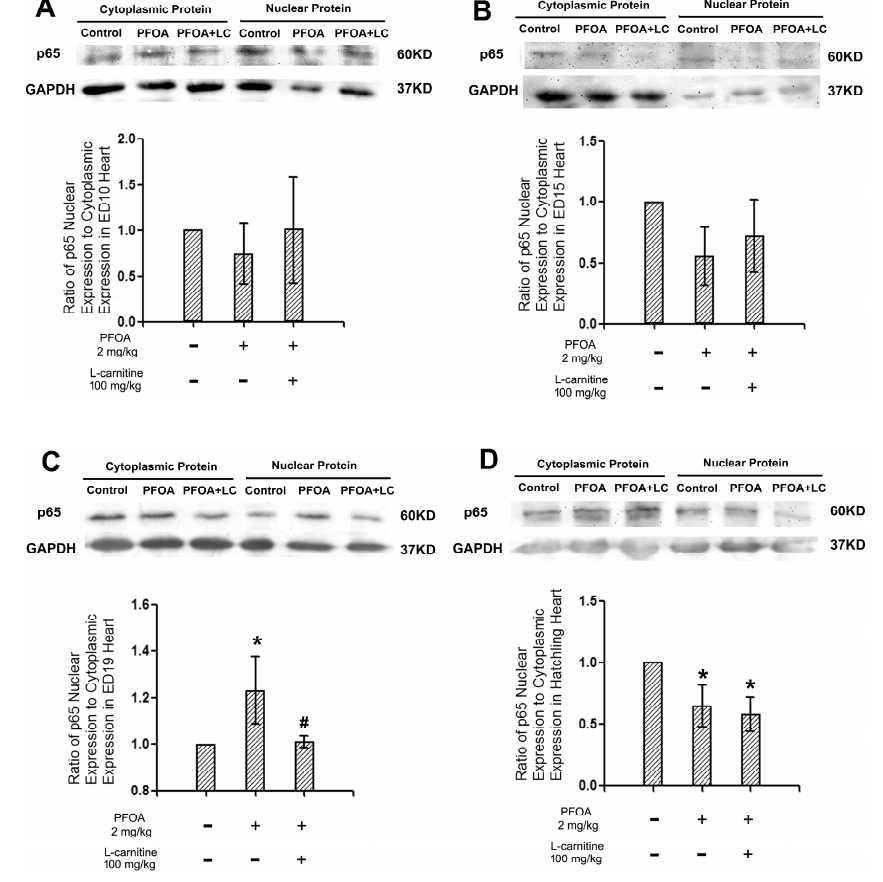
Figure 4. Western blotting for p65 translocation in ED10, 15, and 19 chicken embryo hearts and